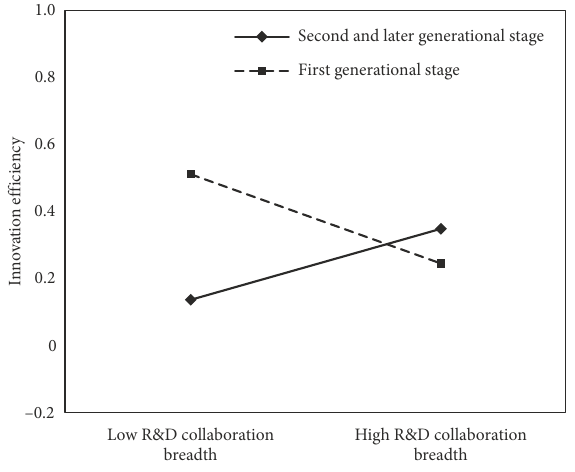
Low R&D collaboration Figure 3. Moderating influence of the generational stage on the R&D collaboration breadth-innovation efficiency relationship